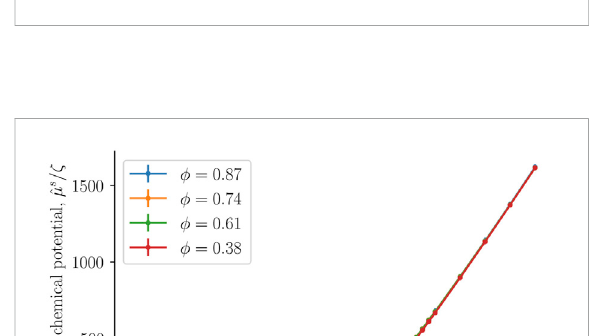
FIGURE 7 Thenegativereplicaenergydensity − x = − X / V asafunctionof the fl uid chemical potential μ f at varying porosities ϕ = V f / V .